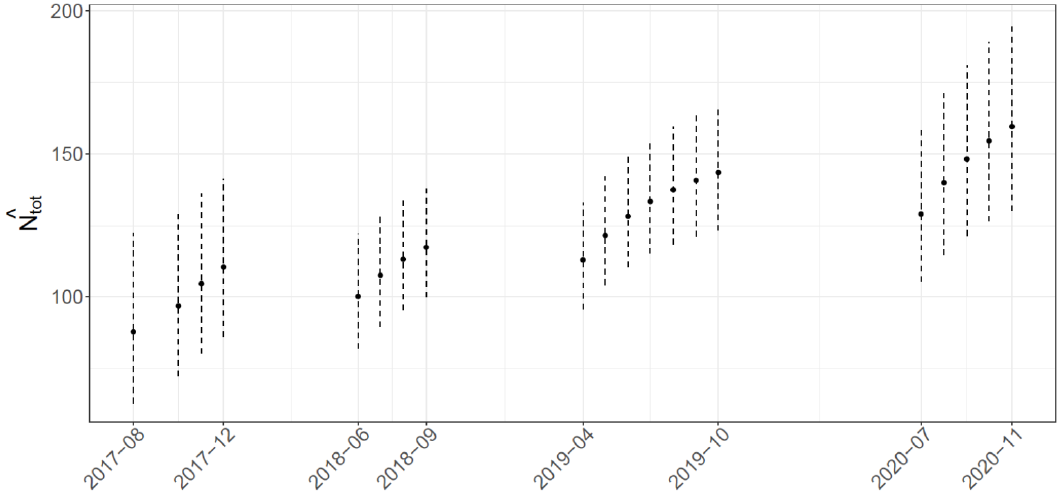
Figure 3. Estimated abundance by each sampling occasion.